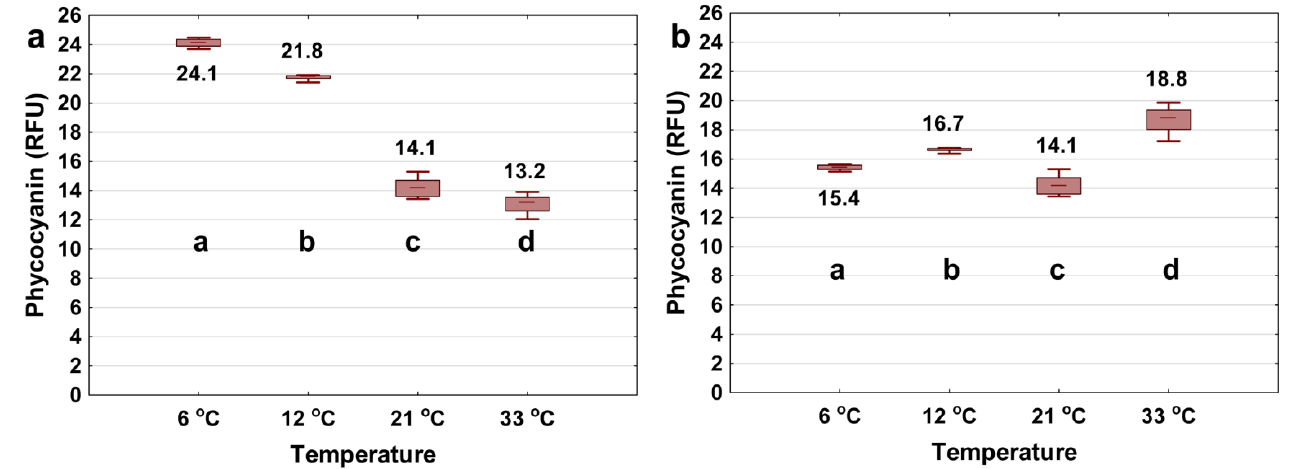
Figure 4. Phycocyanin readings (RFU) using the YSI EXO2 probe of 1 mg/L extract phycocyanin pigment in 6, 12, 21, 33 °C of ultrapure water. All samples were tested over the period of 10 min. The probe measured each of the sample at a 250 ms interval for 10 min ( a ). In ( b ) the temperature interference was removed by adjusting the raw data to a reference temperature of 21 °C using Equation (3). The bottom and top of each box represent the 25th–75th percentiles, respectively. The whiskers represent the minimum and maximum values. The line within each box corresponds to the median value. Different letters represent significant differences between treatment comparisons (Kruskal–Wallis followed by Dunn’s post hoc test, p ≤ 0.05).